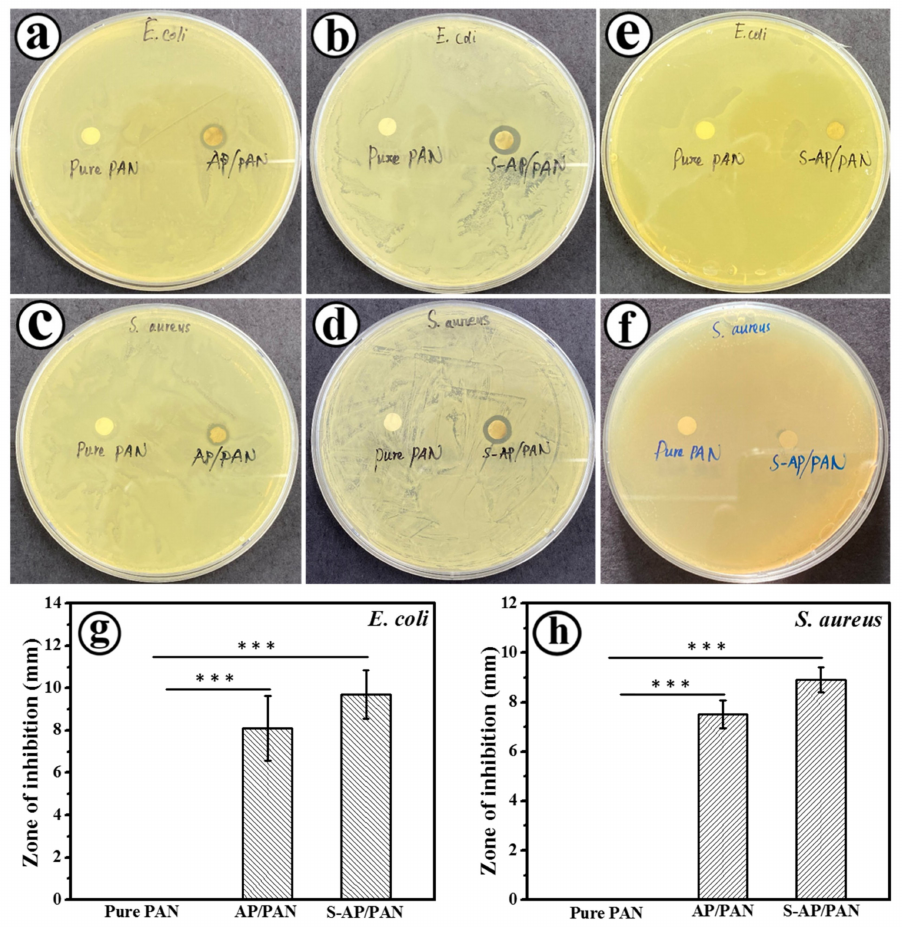
Figure 7. Disk di ff usion test on E. coli ( a , b ) and S. aureus ( c , d ) by pure PAN, AP / PAN and S-AP / PAN. Panels ( e ) and ( f ) represent disk di ff usion test on E. coli and S. aureus , respectively by pure PAN and S-AP / PAN in dark condition. AP / PAN and S-AP / PAN showed significant levels of zone of inhibition on E. coli ( g ) and S. aureus ( h ) compared to Pure PAN statistically assessed by one-way ANOVA using SPSS software. p < 0.05 considered as significant and represented as * p < 0.05, ** p < 0.01 and *** p < 0.001.